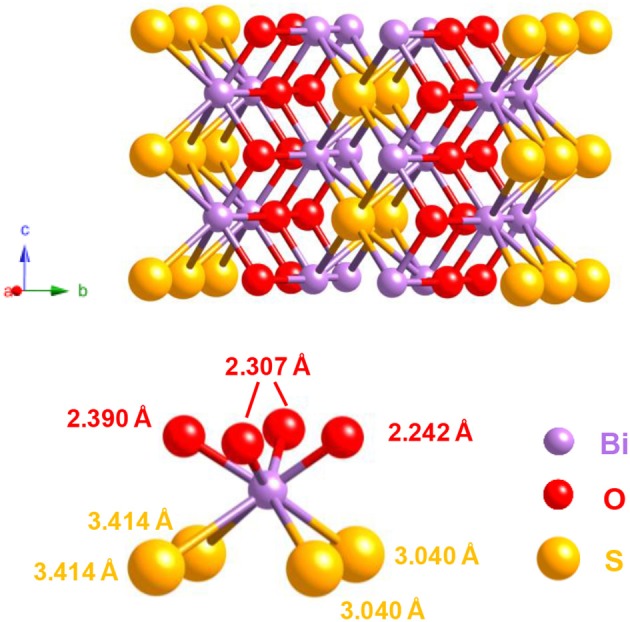
Structure of Bi2O2S (JCPDS 10-2907) and bismuth coordination in the solid.